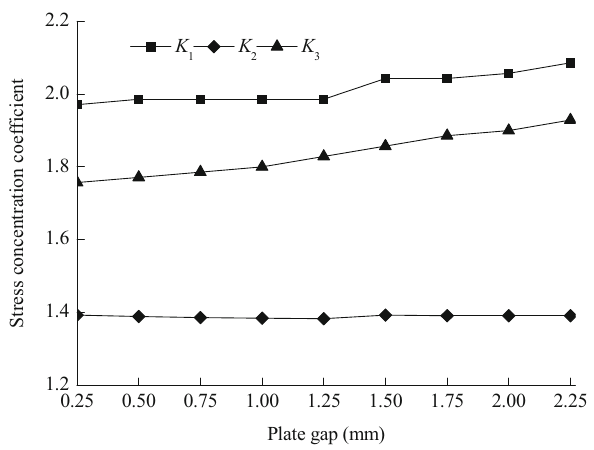
Fig. 13 Relationship between the SCC and weld penetration